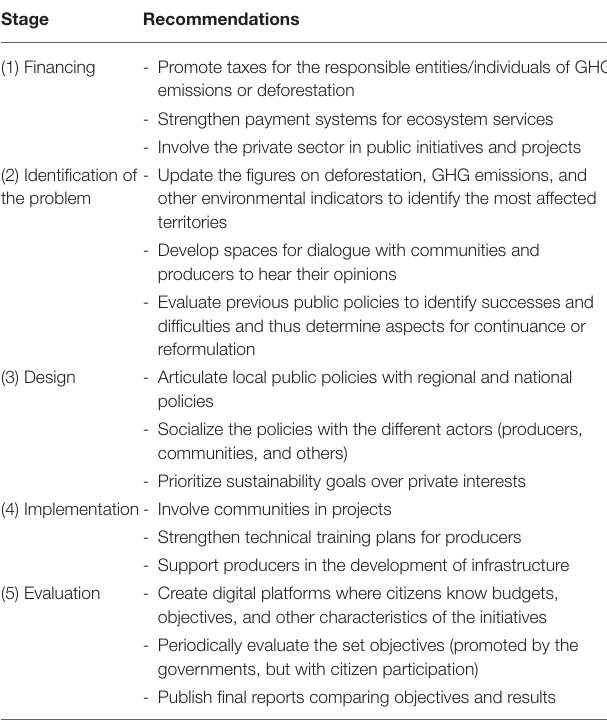
TABLE 7 | Recommendations for the design and implementation of public policies. Stage